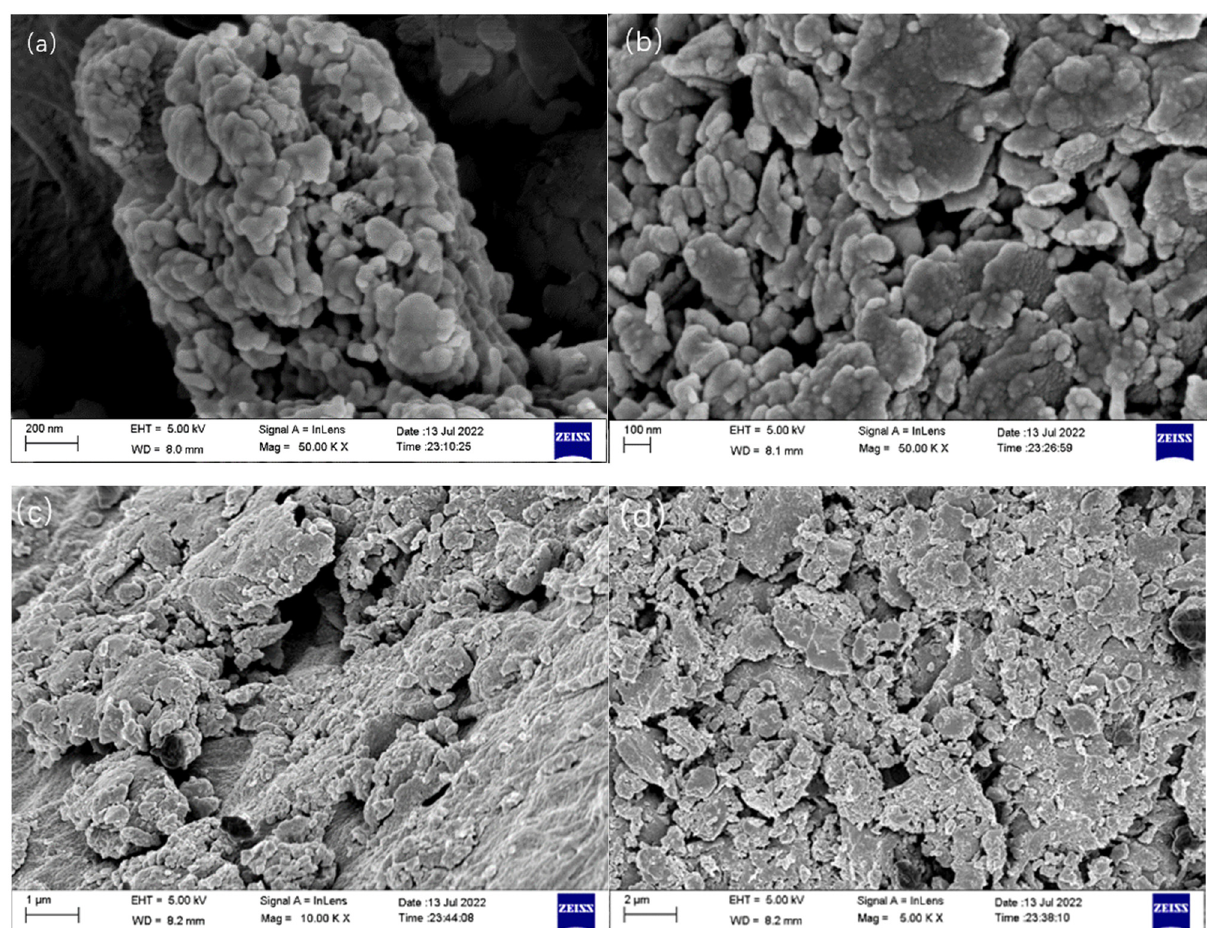
Figure 2: SEM images of ( a and b ) the composite hydrogel and ( c and d ) kaolin.